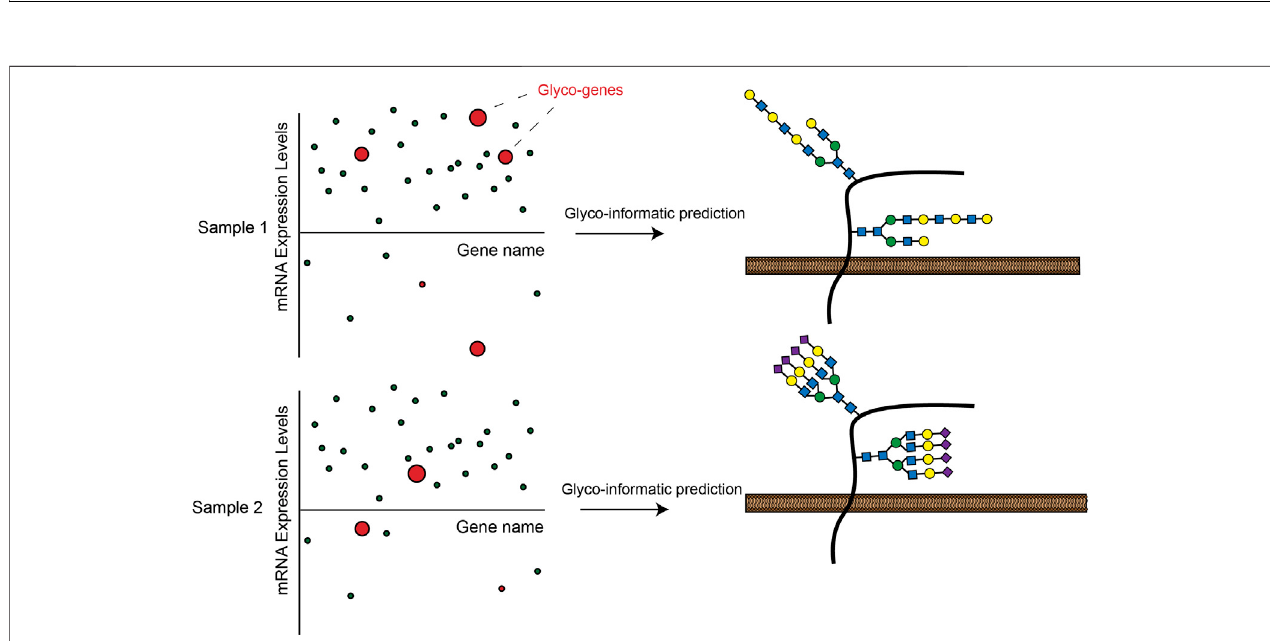
FIGURE 3 | Expression of GT enzymes in RNA-seq datasets can be used to informatically predict a possible cell-surface glycosylation state in a given cell line. These analyses can lead to insights into how glycosylation is differentially regulated across cells and tissues.